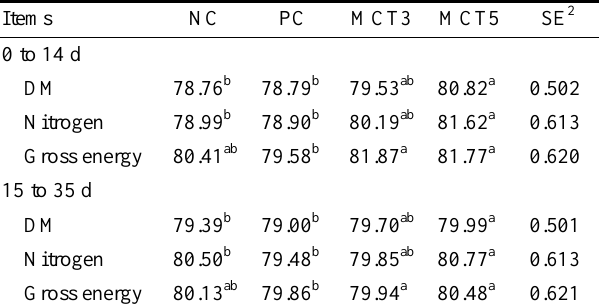
treatments were as follows: NC = Negative control diet; PC = Positive control diet with 40 mg/kg Tiamulin, 110 ppm Tylosin, and 10 mg/kg Enramycin. MCT3 = NC+0.32% medium-chain-triglyceride. MCT5 =